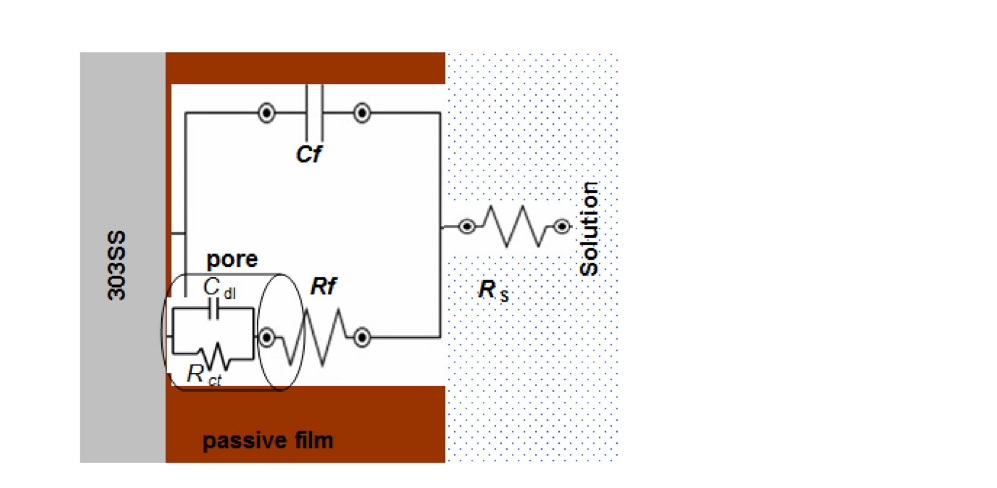
Figure 4. Equivalent circuit to fit the impedance bare 303 SS in 1.0 M H 2 SO 4